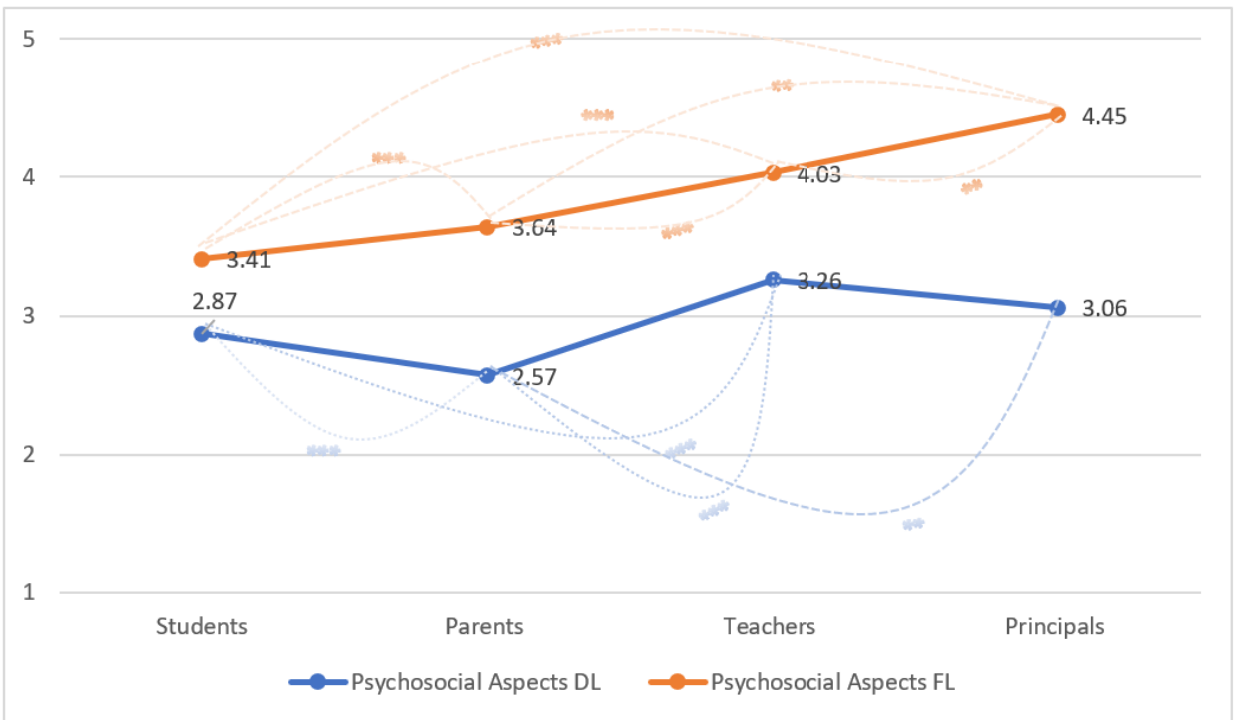
Figure 2. Psychosocial Aspects Index (Distance Learning and Frontal Learning) according to the four stakeholders (Students, Parents, Teachers, Principals) Note: F = 29.91, p < 0.001 for differences for distance and frontal learning according to stakeholder as a result of repeated measure test. Statistical significance denoted as * ( p -value less than 0.05 (*); p -value less than 0.01 (**), p -value less than 0.001 (***) according to Bonferroni multiple comparisons test.